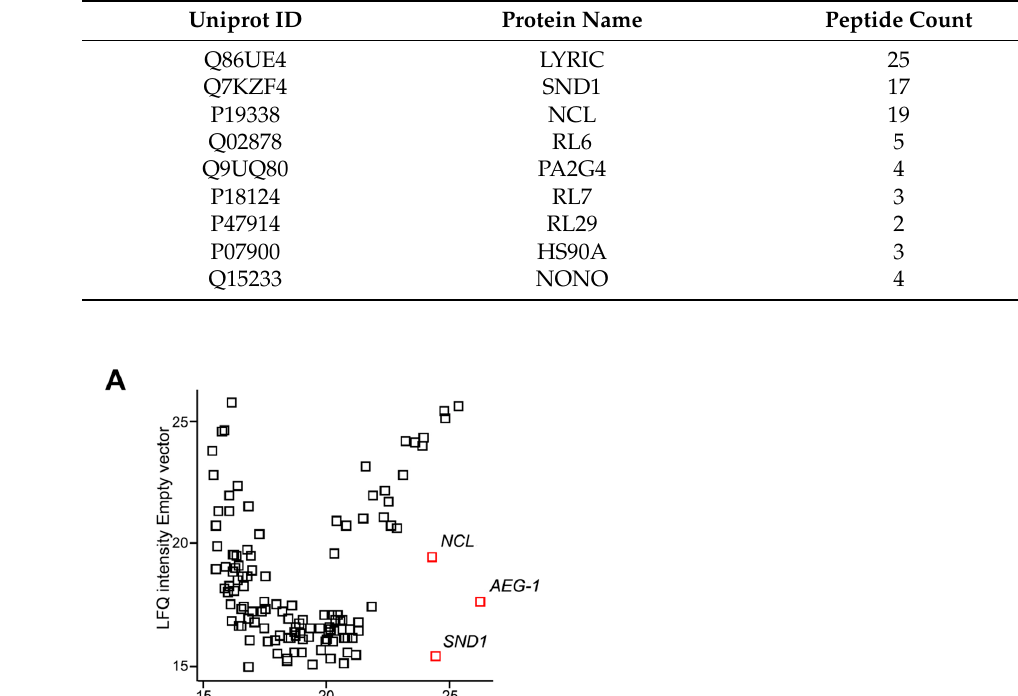
Table 1. List of AEG-1 interacting proteins revealed by LC-MS/MS analysis.